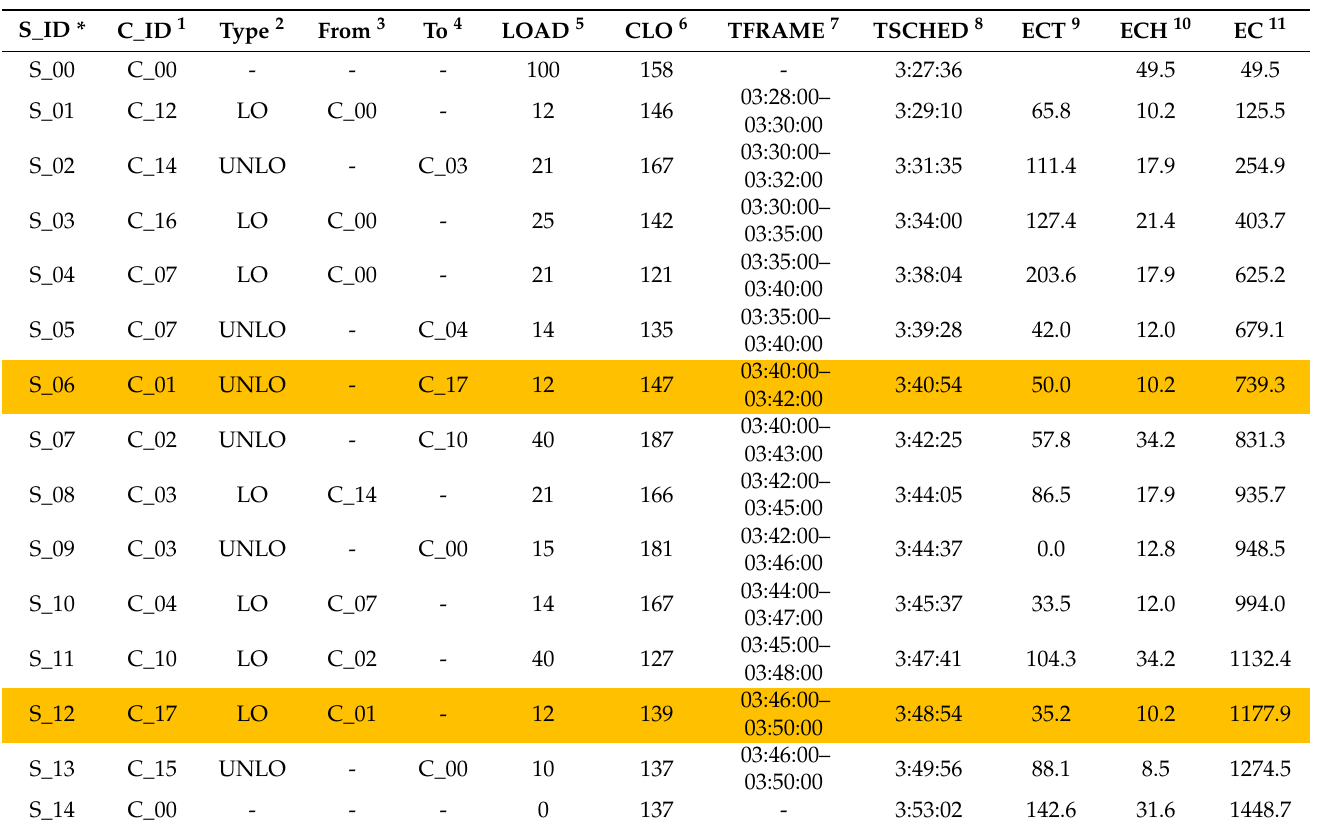
Table 9. Numerical results of the scheduling of predefined and real-time-generated specific in-plant material supply operations performed by the milk-run trolley within route 1. The colored rows represent the real-time added supply demands generated by the supervisory level using the results of the optimization based on the digital twin